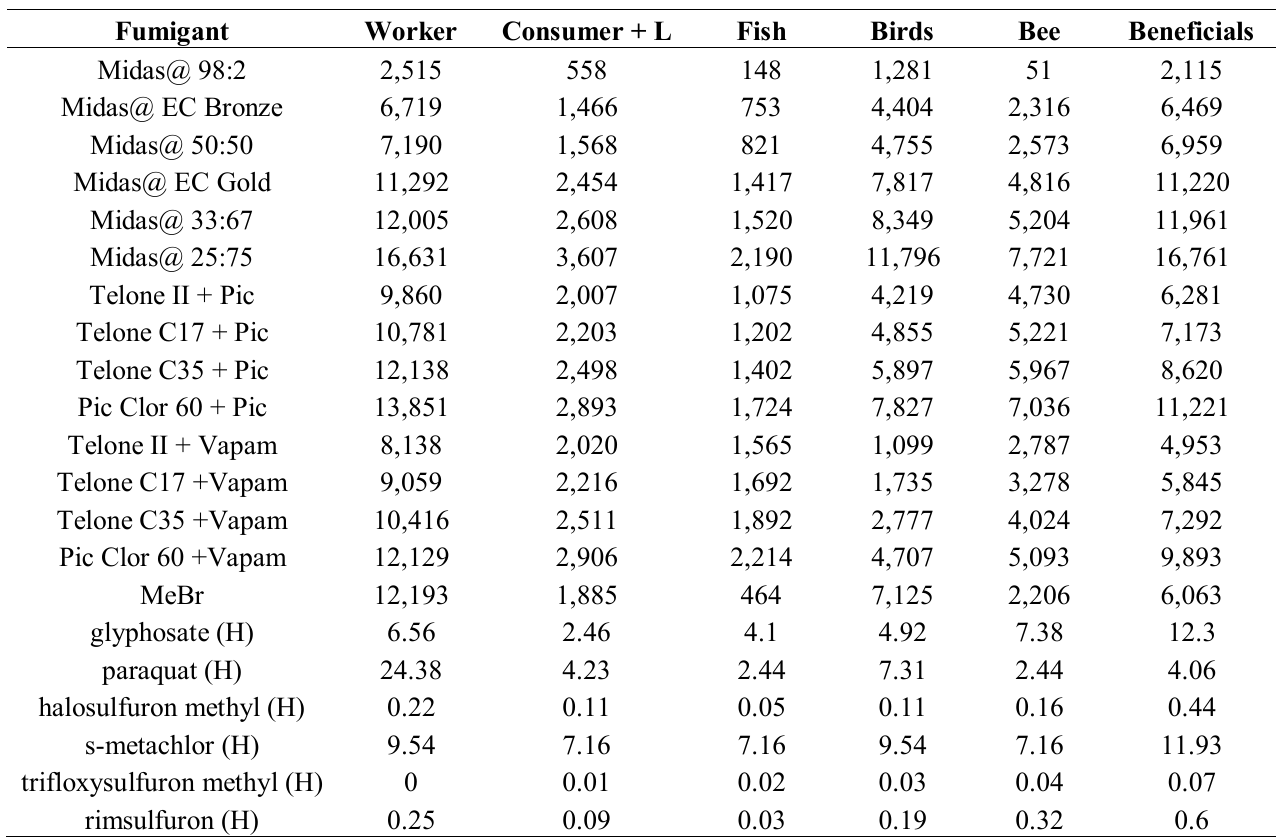
Table 8. Field Use EIQ by environmental